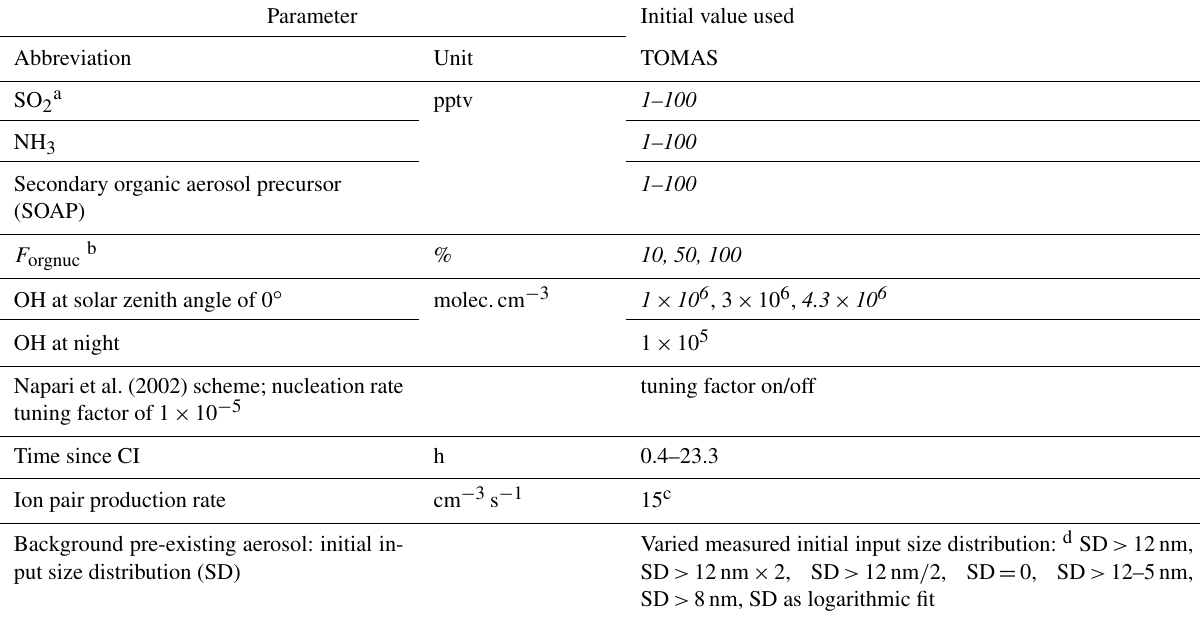
Table 1. Ranges of parameters used for sensitivity studies in the TOMAS box model. Values varied to match the observed size distribution are in italic